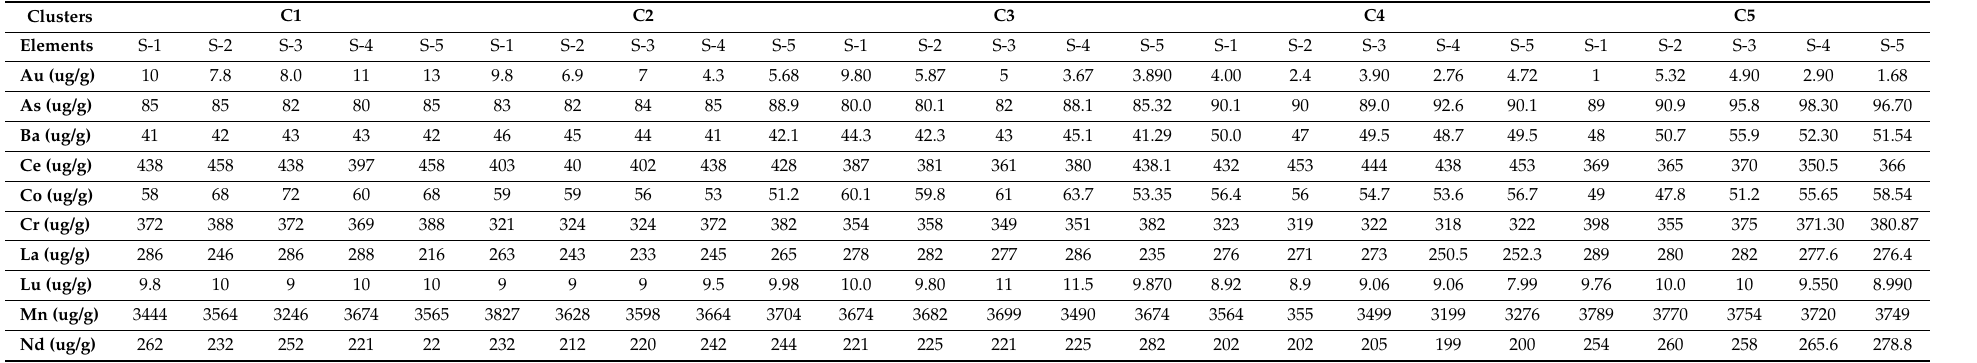
Table 5. Trace element concentration in the different samples of each